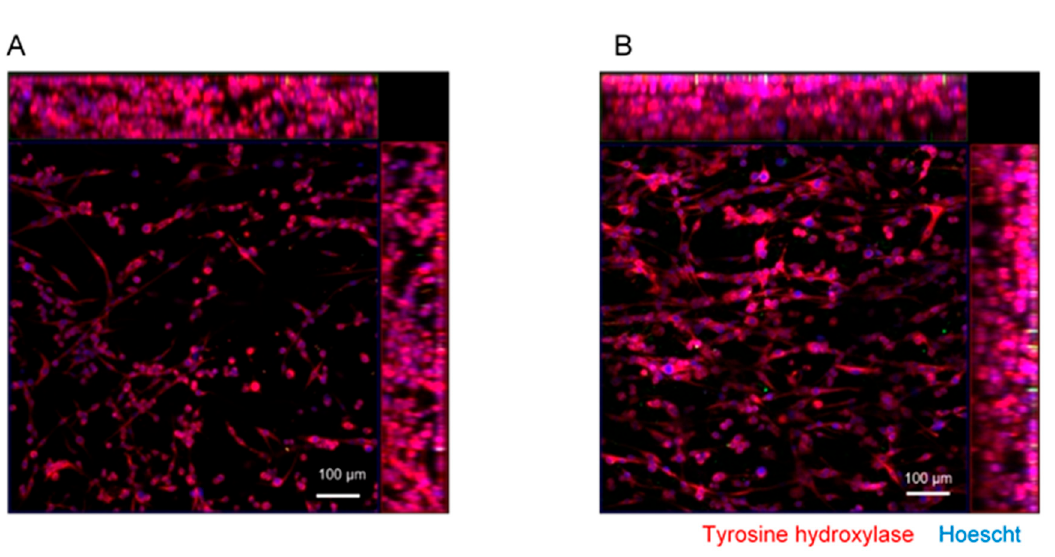
Figure 4. SH-SY5Y cell differentiation on m-rGO/collagen hydrogel scaffolds. Representative confocal immunofluorescence images of random ( A ) and aligned ( B ) collagen scaffolds. The cells were stained for the mature neuronal marker tyrosine hydroxylase (red); nuclei were stained with Hoechst (blue).